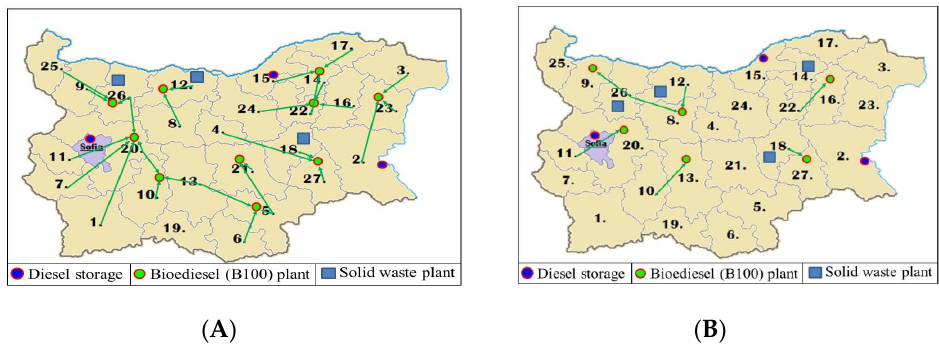
Figure 3. ( A ) Minimum total GHG emissions. ( B ) Minimum total annual costs. Optimal structure of IBDSC and logistics for delivery of sunflower and rapeseed as feedstock for 2020.